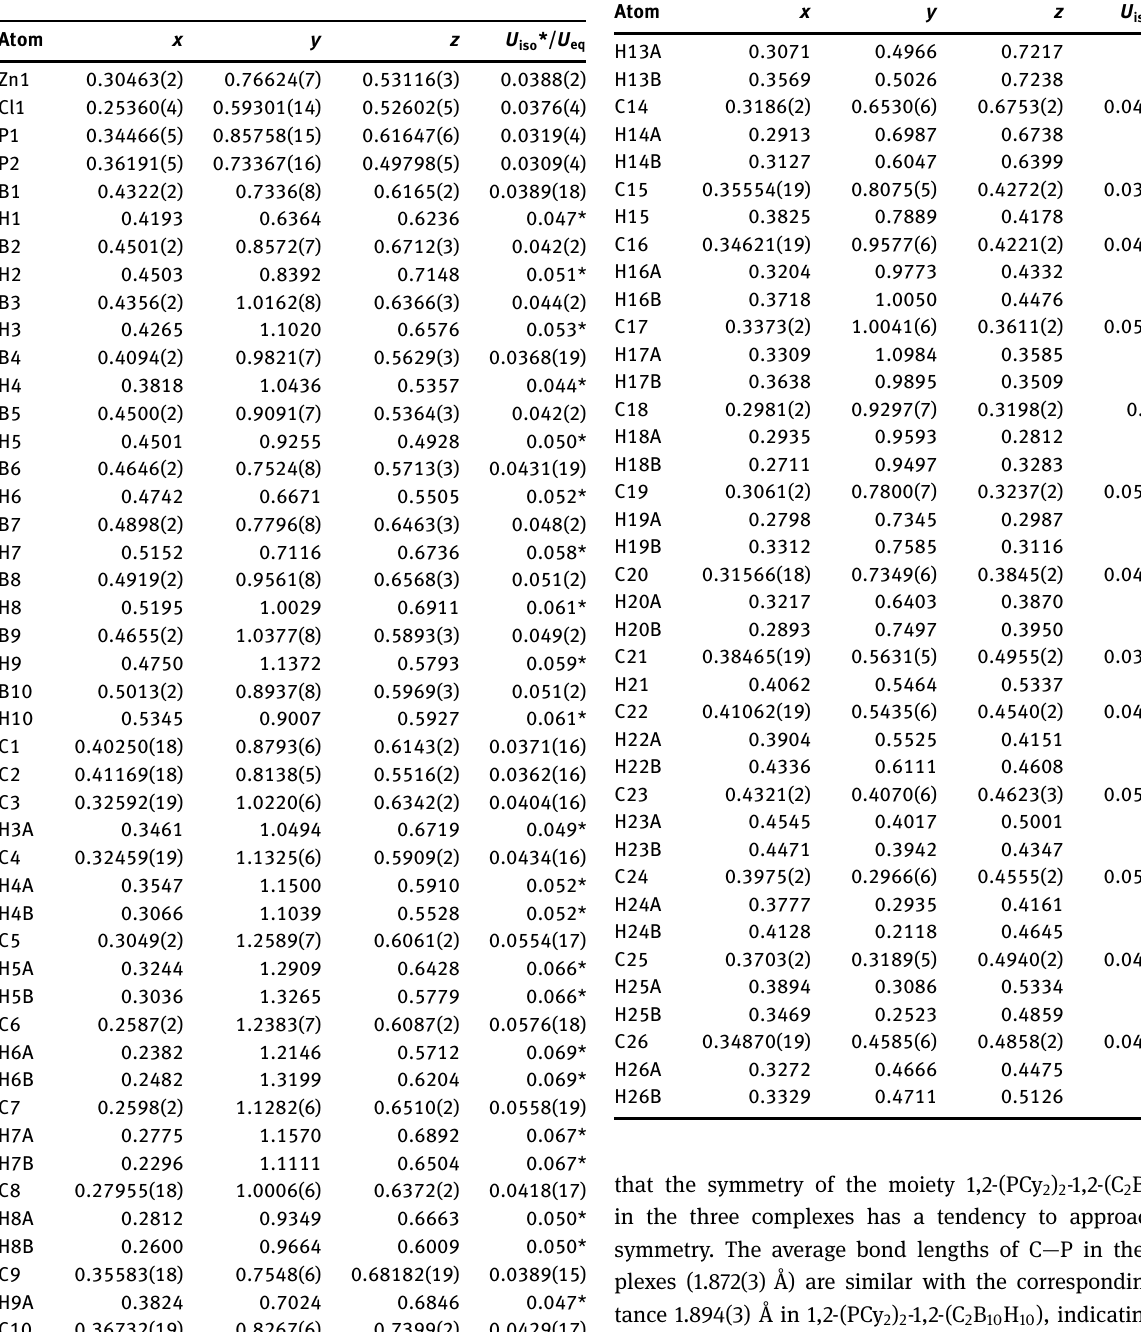
Table 2: Fractional atomic coordinates and isotropic or equivalent isotropic displacement parameters (Å 2